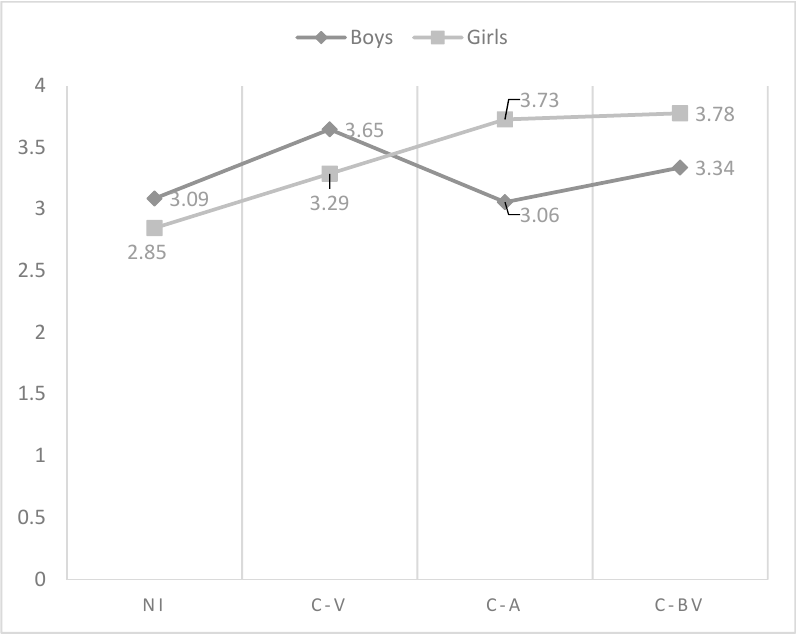
Figure 2. Effect of the interaction of gender and cyberbullying roles on mother psychological control.